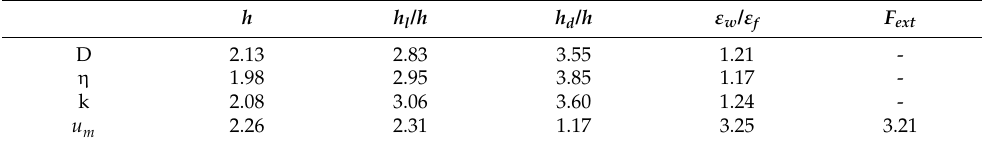
Table 3. Variation inflation factors (VIFs).